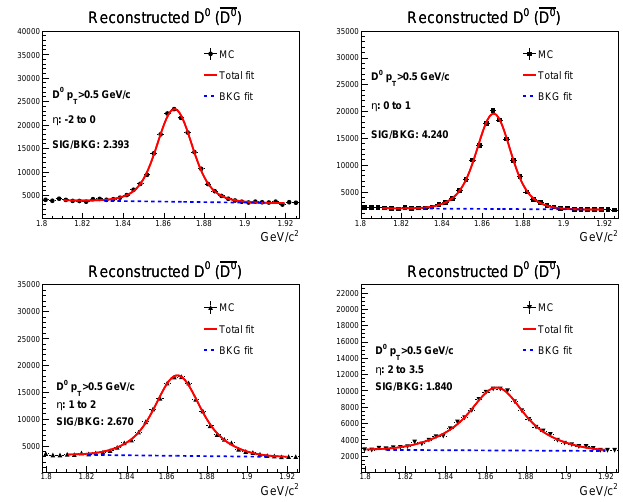
Figure 3: Reconstructed D 0 ( ¯ D 0 ) mass spectrums in four different pseudorapidity re- gions with the evaluated silicon tracking detector performance using the Babar mag- net (shown in the top row of Figure 1) in 63.2 GeV e + p collisions with integrated luminosity of 10 f b − 1 .